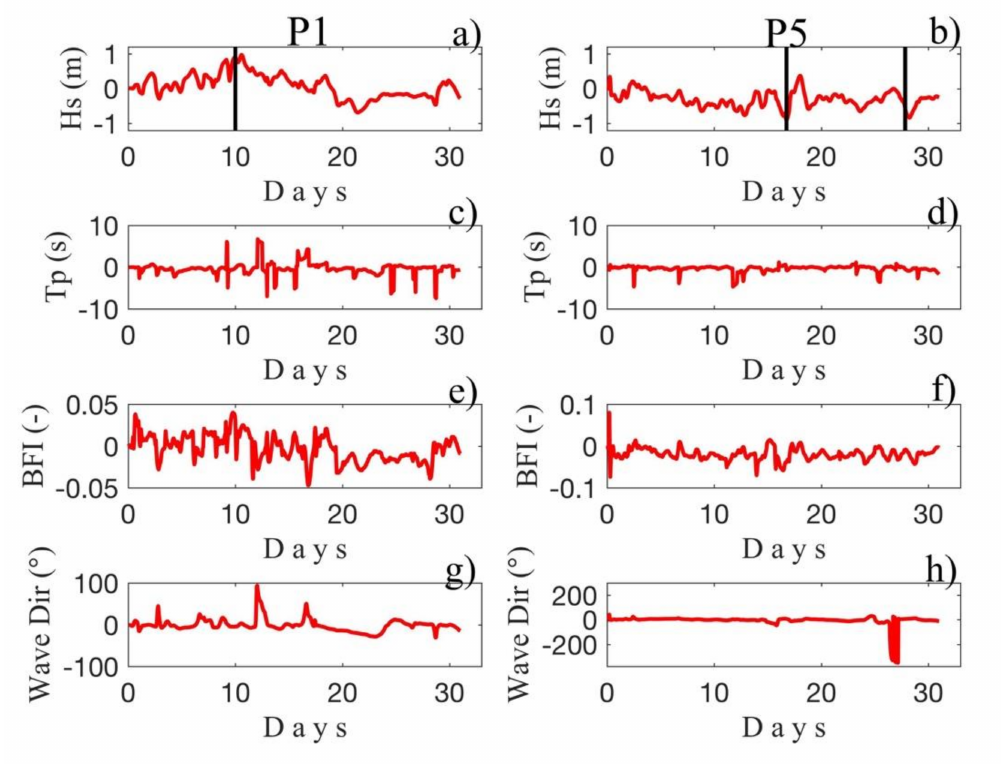
Figure 6. Differences (WCur-WWav) between the different averaged wave parameters. Left (at P1), Right (P5): Hs ( a , b ); Peak Period Tp ( c , d ); BFI ( e , f ); Mean wave propagation direction ( g , h ). Simulation period: 15 June 2018–15 July 2018. Vertical black lines indicate the date where the 2d wave spectra are analyzed in Section 4. (WWav) considering only waves and considering waves and currents (WCur).